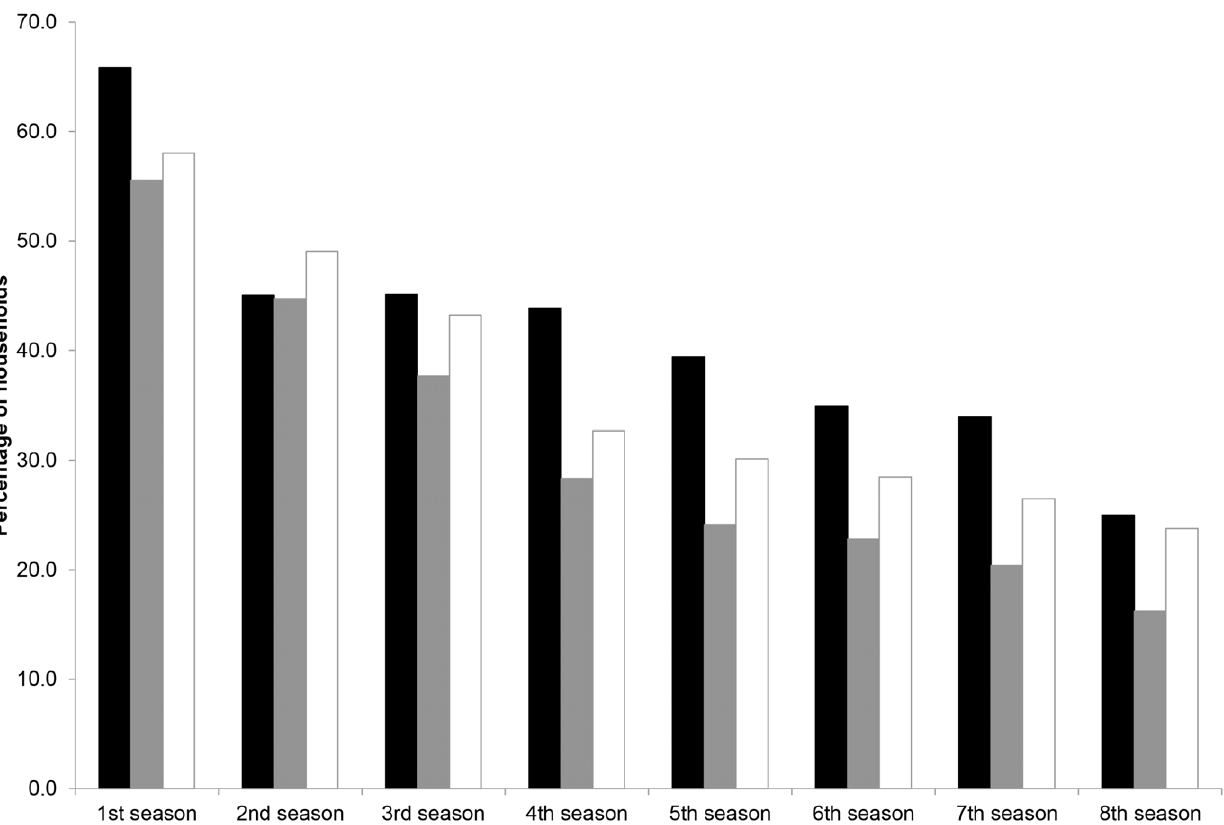
Figure 3. Percentage of single-cat (black) and multiple-cat (grey) households receiving zero prey each season, and the assumed minimum number of cats in multiple-cat households (open bars) delivering zero prey each season (see text for details) in relation to cumulative length of time in study.